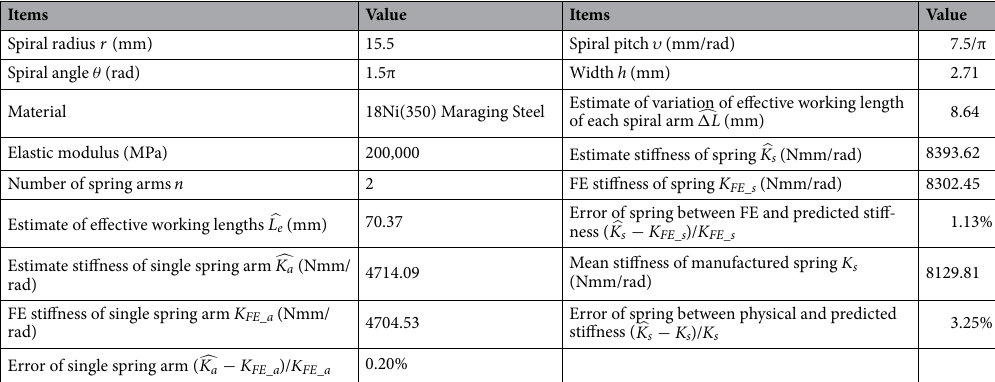
Table 4. Parameters of designed spring arm and corresponding planar spiral spring when thickness is in unit thickness ( b = 1 mm